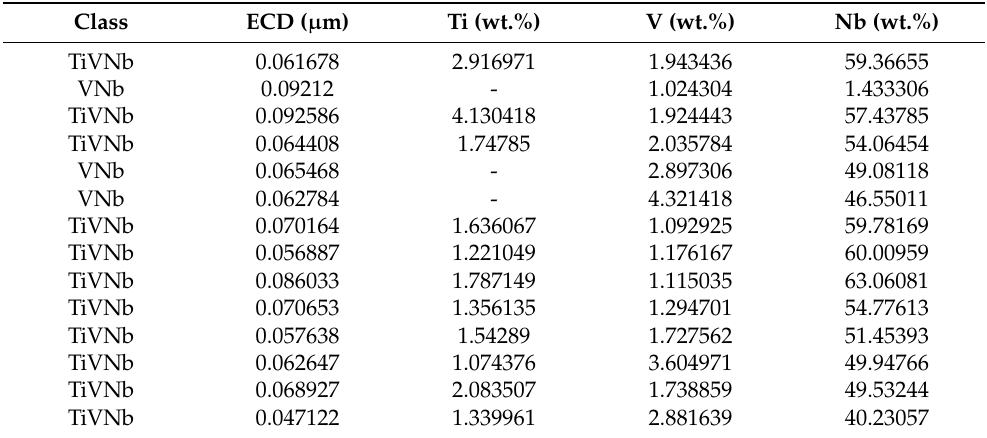
Figure 3. TEM image showing the morphology and the Ti/Nb/V distribution in a random precipitate in steel S1. Table 2. Analysis of particle size and the contents of Nb/V/Ti elements in those precipitates in Figure 2a (steel S1).